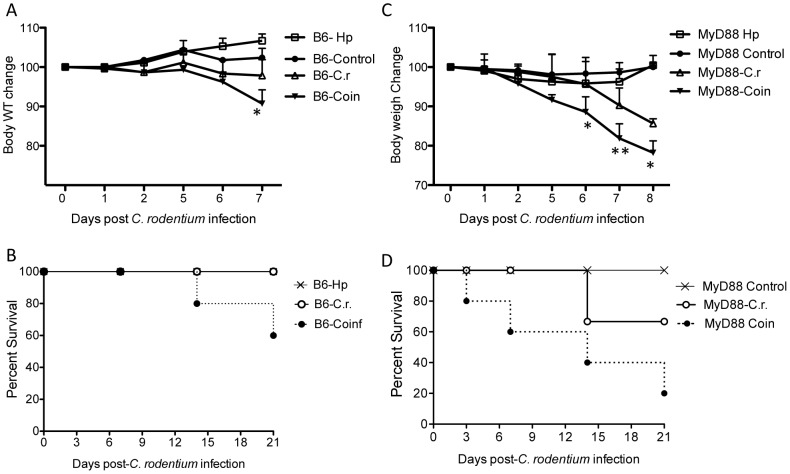
Helminth co-infection exacerbates C. rodentium-induced colitis and mortality in MyD88 KO mice.MyD88 knockout and wild-type C57BL/6 mice were infected with H. polygyrus (200 L3) and inoculated with C. rodentium (5×108 CFU) 7 days later. A & C: Body weight changes of wild-type (A) and MyD88 knockout (C) mice that were infected with C. rodentium, H. polygyrus, both H. polygyrus and C. rodentium, and normal control mice during the course of the experiment (8 days) are shown. Data shown are pooled from three independent experiments and are expressed as the body weight change as a percentage of the individual mouse initial body weight ± SE (n = 10–15) at each time point. B &D: Survival curve in wild-type (B) and MyD88 knockout (D) mice. H. polygyrus co-infection results in a significantly increased mortality in MyD88 KO mice.